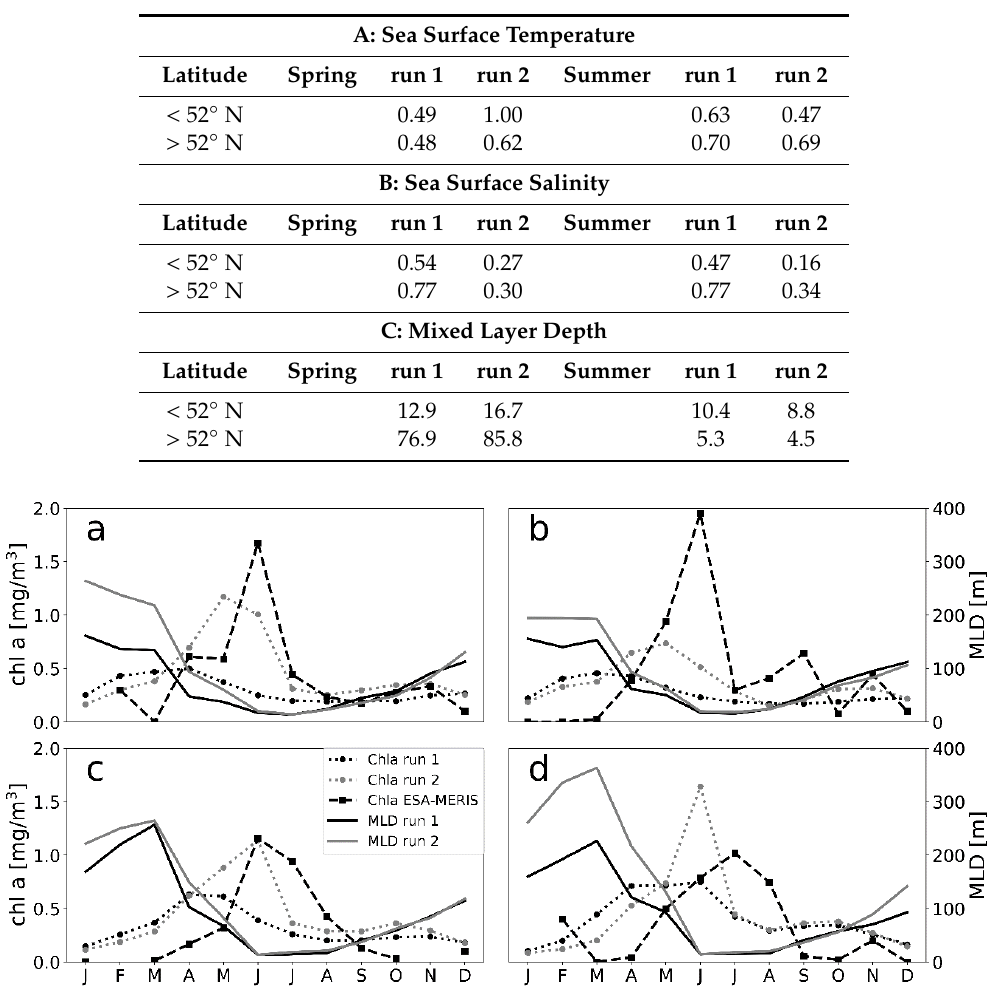
Figure 5. Monthly averages of surface chlorophyll a (Chl a, top 10 m) and mixed layer depth (MLD) of NEMO-PISCES (nucleus for European modelling of the ocean - pelagic interactions scheme for carbon and ecosystem studies) run 1 and 2, combined with monthly averaged remote sensing Chl a (Meris) for stations at 55.7 º N ( a ), 58.7 º N ( b ), 60.1 º N ( c ), and 62.8 º N ( d ) during 2009.